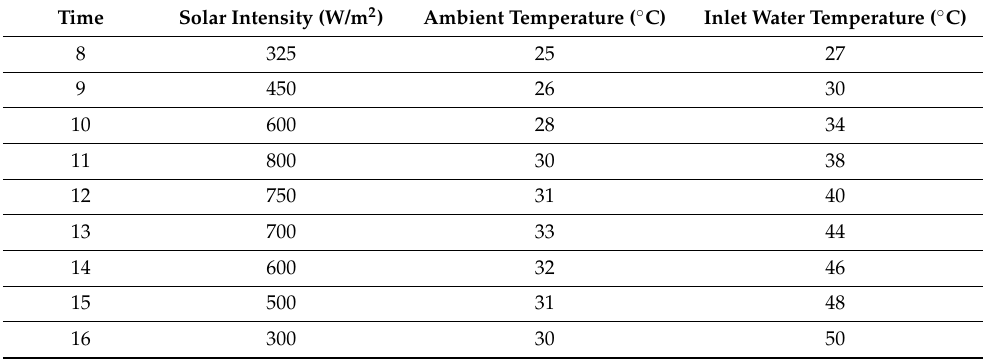
Figure 6. ( a ) Weather conditions of Oussama [18] ( b ) Comparison of the total e ffi ciency of the present work and Oussama [18]. Table 1. Weather conditions of the PVT water collector Table 1. Weather conditions of the PVT water collector [40].